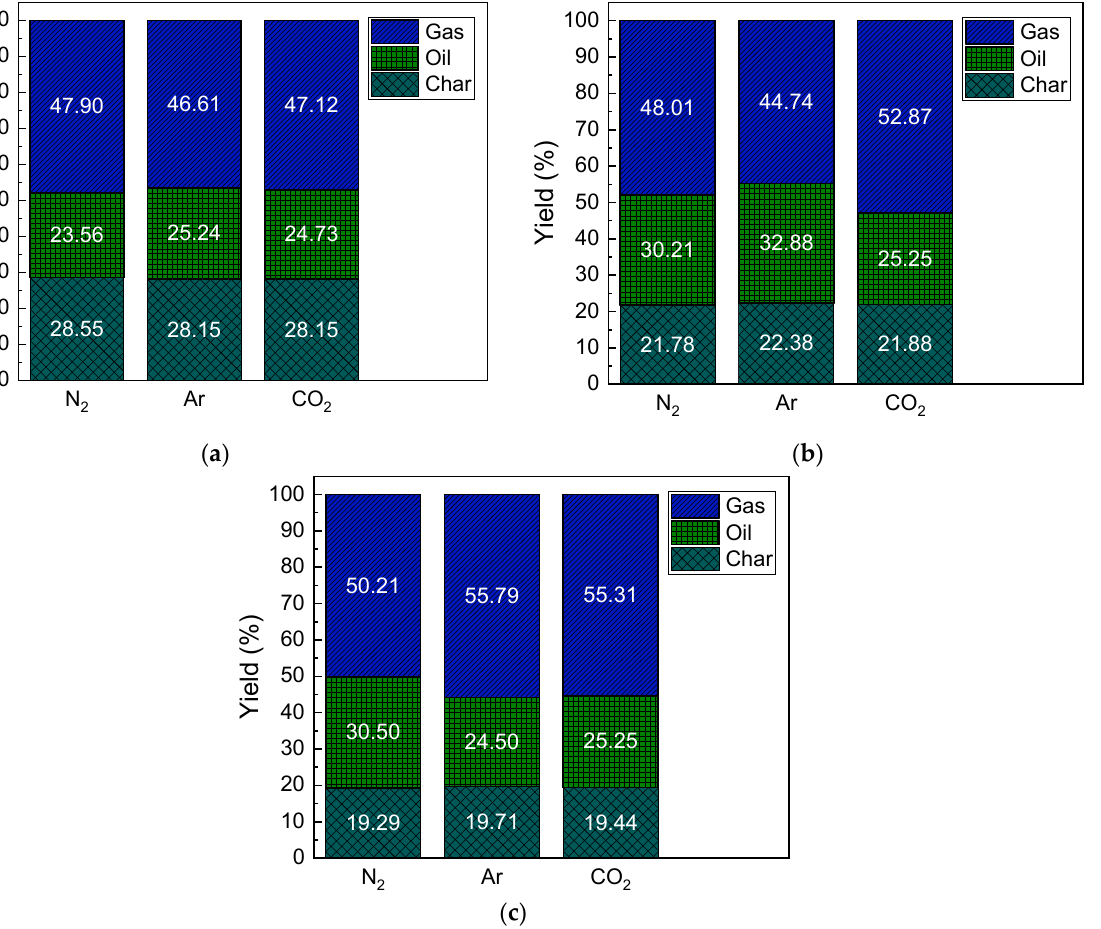
Figure 3. Products yields received from pyrolysis of BSG at ( a ) 500 °C, ( b ) 600 °C, and ( c ) 700 °C.